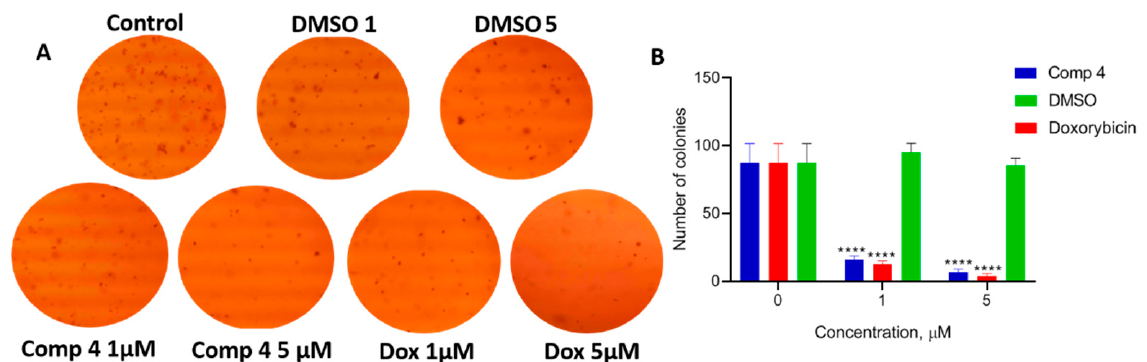
Figure 11. Compound 4 reduces the size and number of colonies of MCF-7 cells. Results of soft agar drug sensitivity assay (day 12). ( A ) Representative cell culture wells. ( B ) Graphical data (**** p < 0.0001 compared with control).